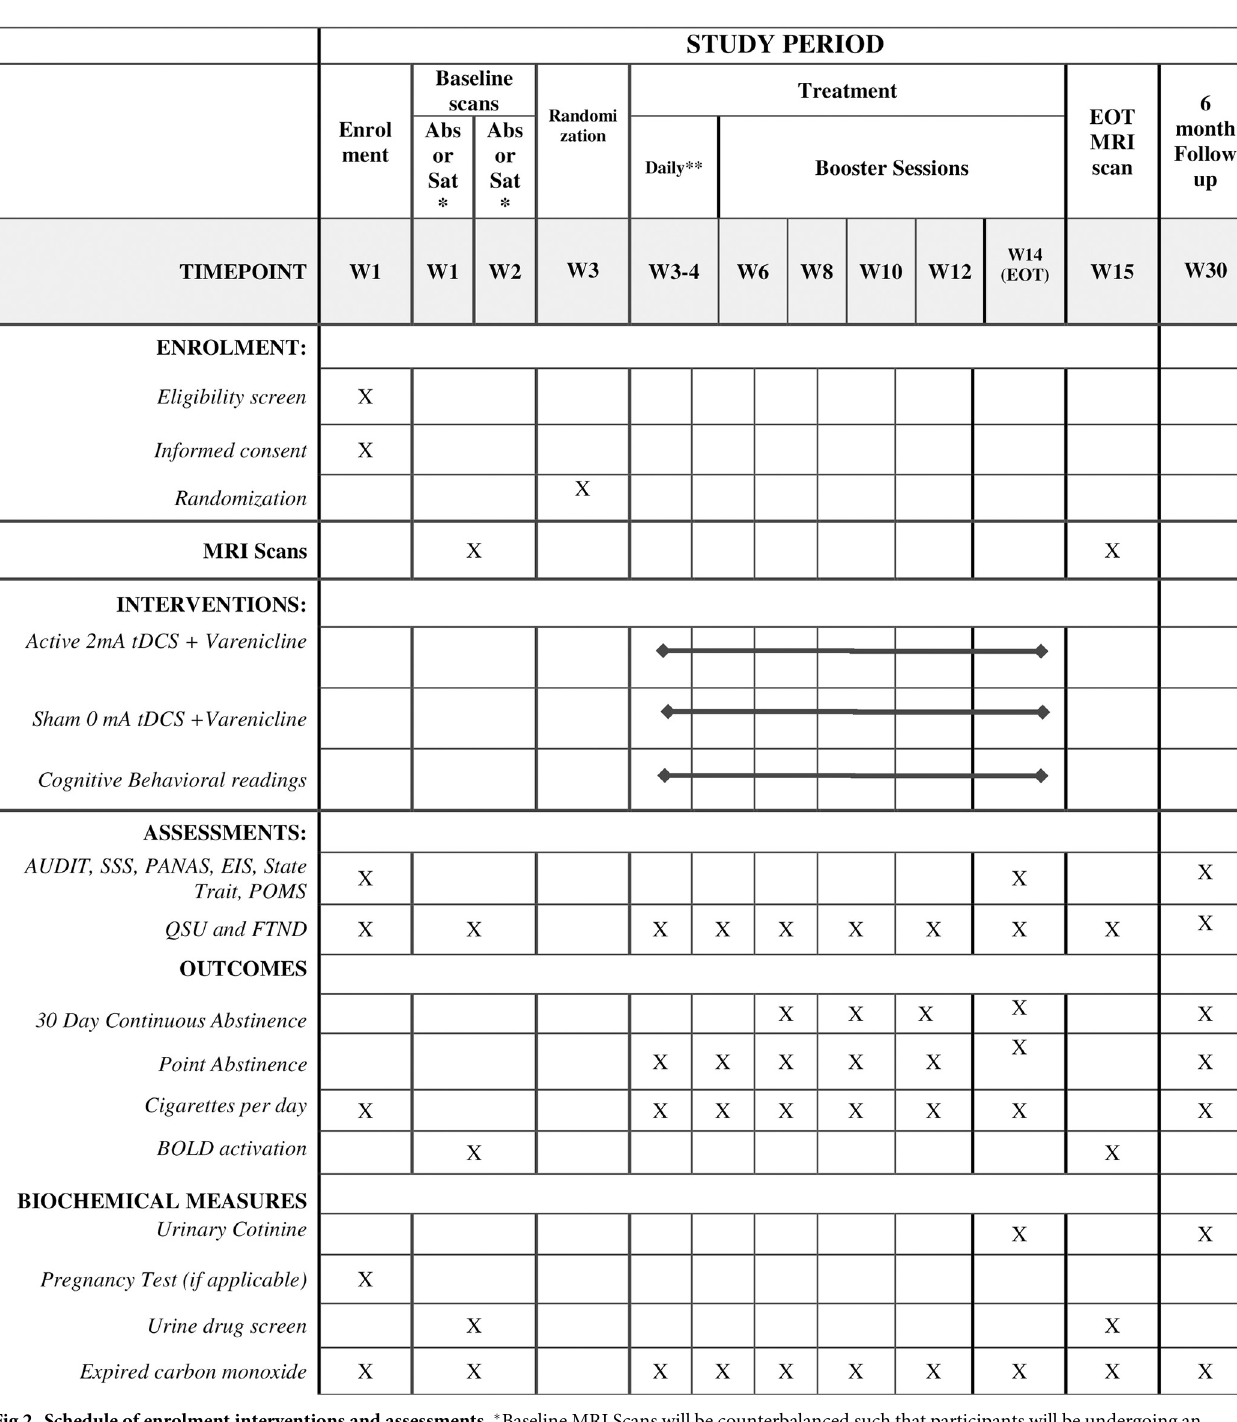
Fig 2. Schedule of enrolment interventions and assessments. � Baseline MRI Scans will be counterbalanced such that participants will be undergoing an abstinence scan and a satiated scan within one week of each other. �� Daily tDCS stimulation over the first 2 weeks. List of abbreviations: MRI = functional magnetic resonance imaging; Eot = end of treatment; PHQ-9 = Patient Health Questionnaire–validated self-completed measure of depressive symptoms mapped on to DSM-IV criteria; QSU-brief = 10-item Questionnaire of Smoking Urges; AUDIT = Alcohol Use Disorders Identification Test; FTND = Fagerstrom Test for Nicotine Dependence; EIS = Eysenck Impulsivity Inventory; SSS = Sensation Seeking Scale; PANAS = Positive and Negative Affect Schedule; State Trait = State Trait Anxiety; POMS = Profile of Mood States.; BOLD = Blood oxygen level dependent signal, functional MRI measure of blood flow; Abs = MRI scan conducted following overnight nicotine abstinence (of at least 10 hours); Sat = MRI scan conducted following nicotine satiety (within 1–2 hours of smoking a cigarette).